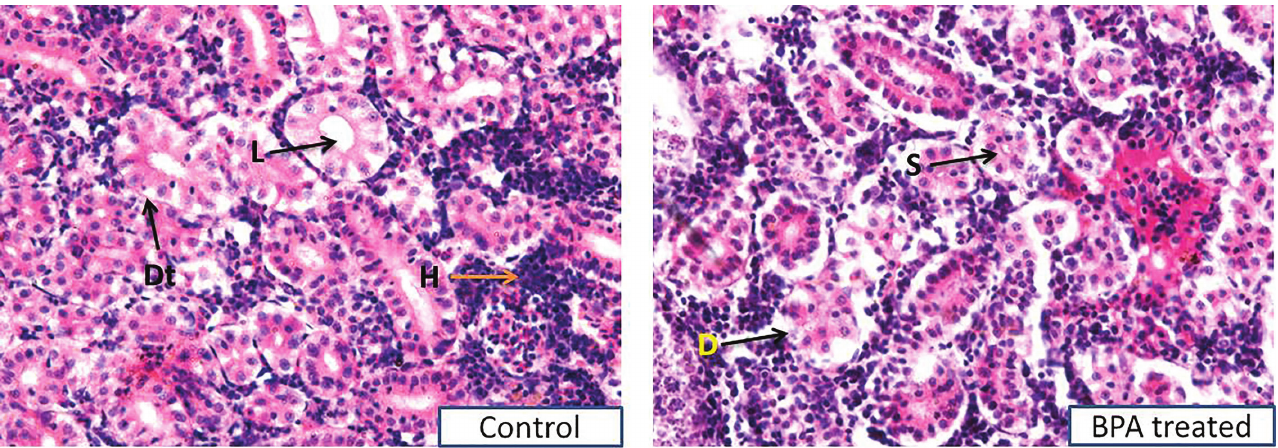
FIGURE 2 - Kidney tissue of C. idella from control and treated group exposed to the sublethal concentration of BPA for 14 days. (H) hematopoietic tissue; (Dt) distal tubules; (L) tube lumen; (D) degeneration of tubules; (S) shrinkage of tube lumen. H & E stain, 40X.